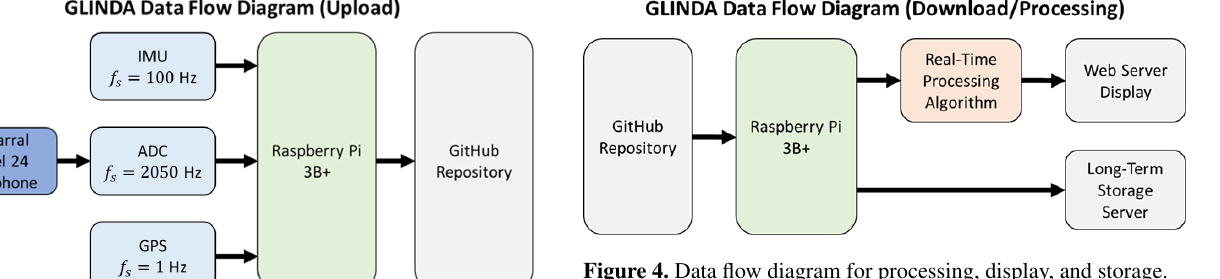
Figure 4. Data flow diagram for processing, display, and